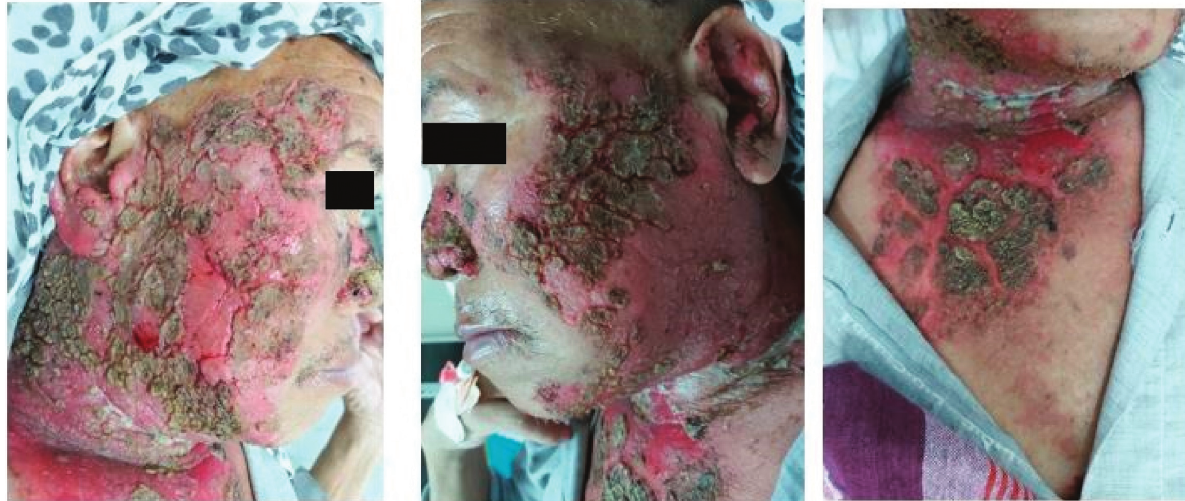
Figure 2: Day 1 of admission: extension of erosions despite high-dose oral steroids.